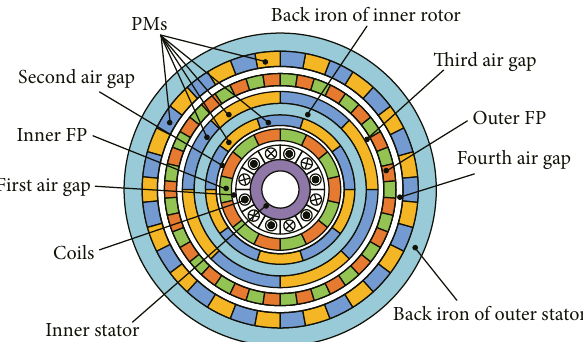
Figure 1: Topology of electromechanical integrated magnetic